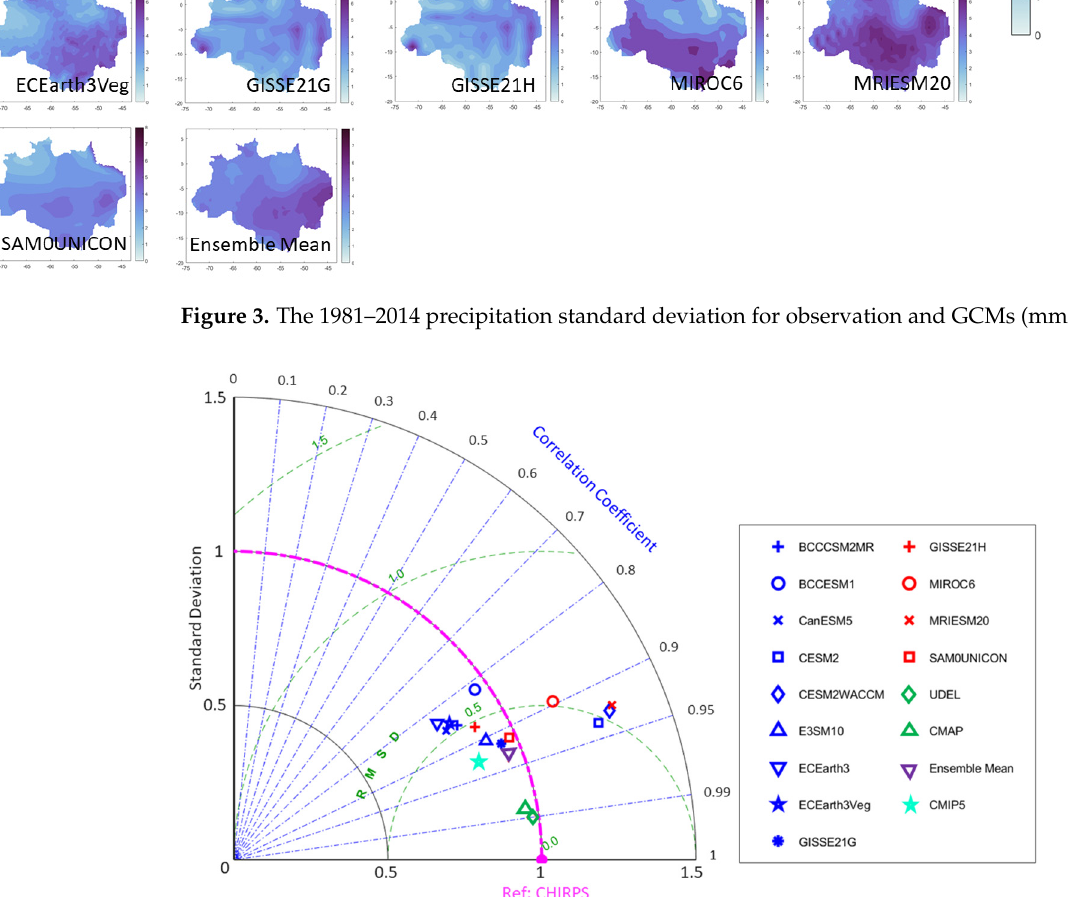
Figure 4. Taylor diagram of daily precipitation for the Brazilian Amazon from 1981 to 2014. CHIRPS is the reference dataset and symbols indicate CMIP6 models, observational datasets, CMIP6 ensemble mean, and CMIP5 ensemble mean. Results have been normalized to CHIRPS standard deviation.